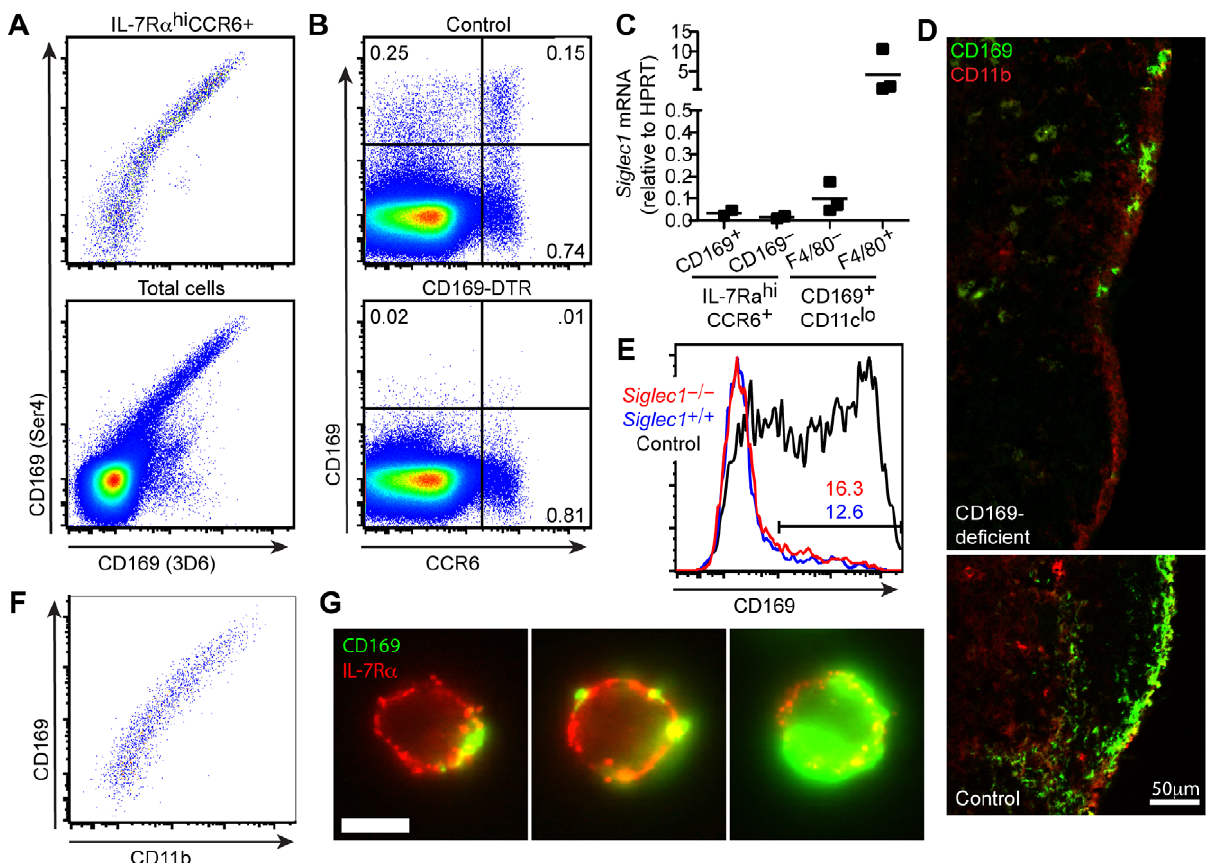
Figure 2. IL-7R a hi CCR6 + lymphocytes acquire CD169 + SSM-derived membrane blebs. (A) Flow cytometric detection of CD169 on digested lymph node cells stained with two anti-CD169 monoclonal antibodies, Ser4 and 3D6. The top panel is pre-gated on IL-7R a hi CCR6 + cells; the bottom panel shows total cells. Data are representative of three independent experiments. (B) Expression of CD169 on total cells from digested lymph nodes from CD169-DTR mice treated with saline or DT 3 or 4 days prior to analysis. Data are representative of two independent experiments. (C) Siglec1 mRNA quantification by RT-PCR in sorted CD169 + and CD169 – IL-7R a hi CCR6 + cells, CD169 + CD11c lo F4/80 – cells, and CD169 + CD11c lo F4/80 + cells. Data are plotted relative to HPRT. (D) Immunofluorescence microscopy of lymph nodes stained with anti-CD169 and anti-CD11b monoclonal antibodies from a Siglec1 –/– bone marrow chimeric mouse (top panel) or control non-chimeric mouse (bottom). Scale bar=50 m m. Data are representative of one experiment. (E) Flow cytometric detection of CD169 staining on CD45.1 + Siglec1 + / + radiation-resistant (blue) compared to donor bone-marrow- derived CD45.2 + Siglec1 –/– (red) IL-7R a hi CCR6 + cells. CD169 + staining on IL-7R a hi CCR6 + cells from a non-chimeric control animal are represented in black. Data are representative of two experiments. (F) Flow cytometric detection of CD169 and CD11b on IL-7R a hi CCR6 + cells from digested lymph nodes. Data are representative of two experiments. (G) CD169 + IL-7R a hi CCR6 + B220 2 cells from digested lymph nodes were sorted and fixed to a slide for immunofluorescence microscopy. Data are representative of one